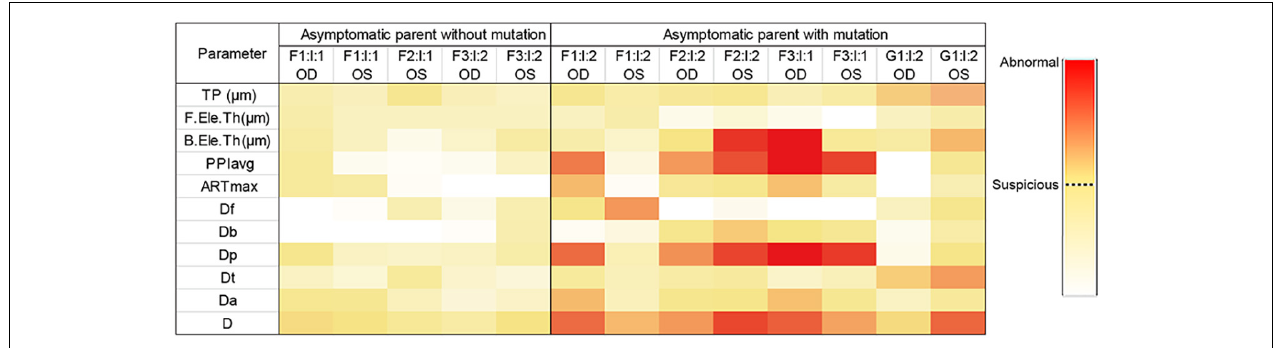
FIGURE 4 | Heatmap of parameters from Pentacam of the parents in the four families. Data visualization was carried out based on the different value range of each parameter, and the darker color represents the higher probability of anomaly. *Data of the right eye of F2: I:1 was excluded from our study because of pterygium, corneal macula, and explicit history of trauma. OD, right eye; OS, left eye.